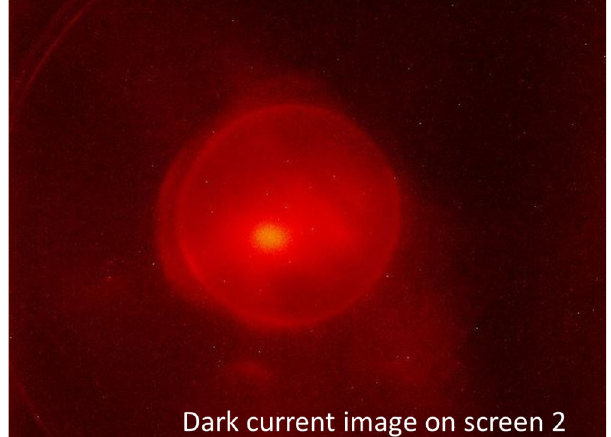
FIG. 3. The image of the dark current focused with the solenoid on the YAG screen 2.